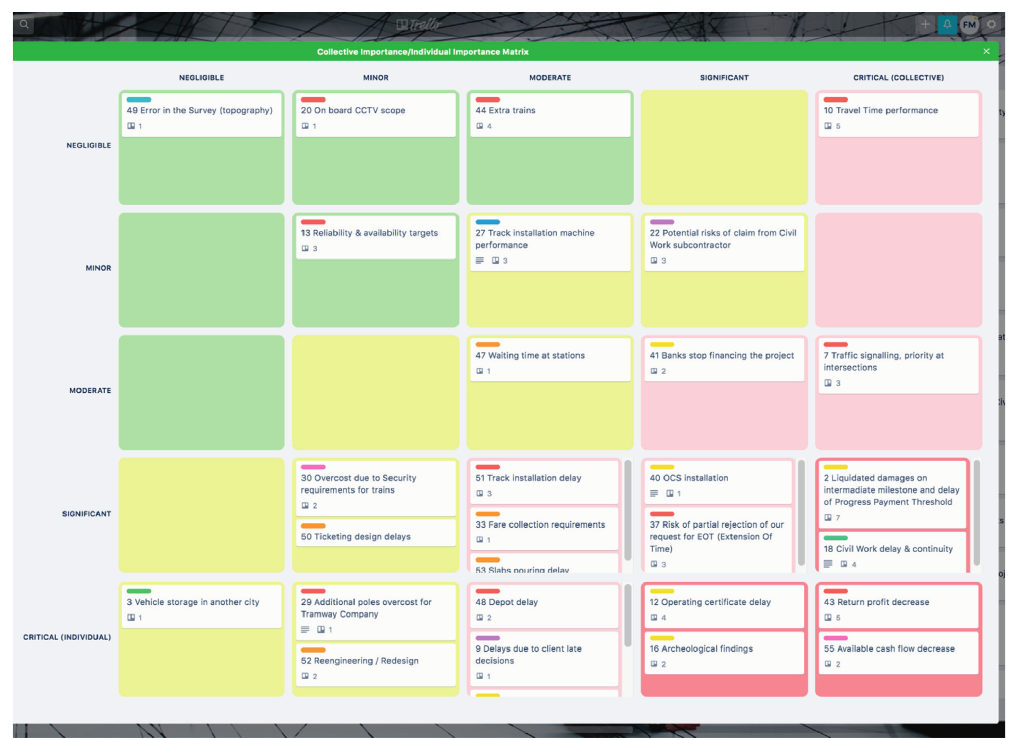
Figure 6: Illustration of an original Farmer-like diagram combining Individual and Collective Importance of